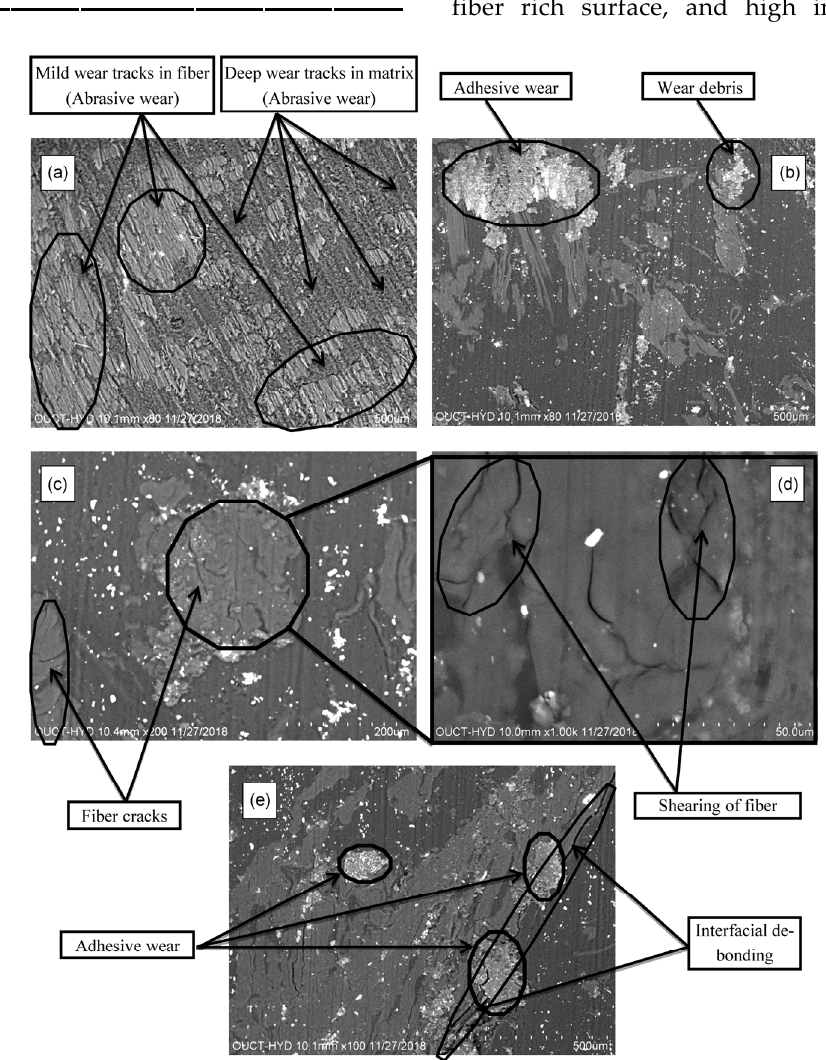
Fig. 9 Worn surface SEM micrographs of composites for the conditions: (a) FL-5 mm, NL-45 N, SD-2,000 m; (b) FL-10 mm, NL-30 N, SD-3,000 m; (c) FL-15 mm, NL-45 N, SD-1,000 m; (d) magnified image of (c); and (e) FL-20 mm, NL-15 N, SD-1,000